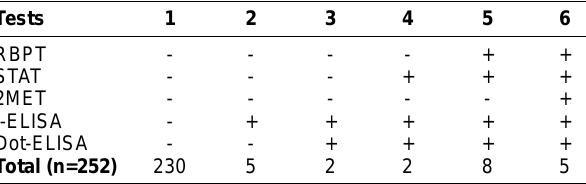
Table-2: Prevalence using combination of different tests